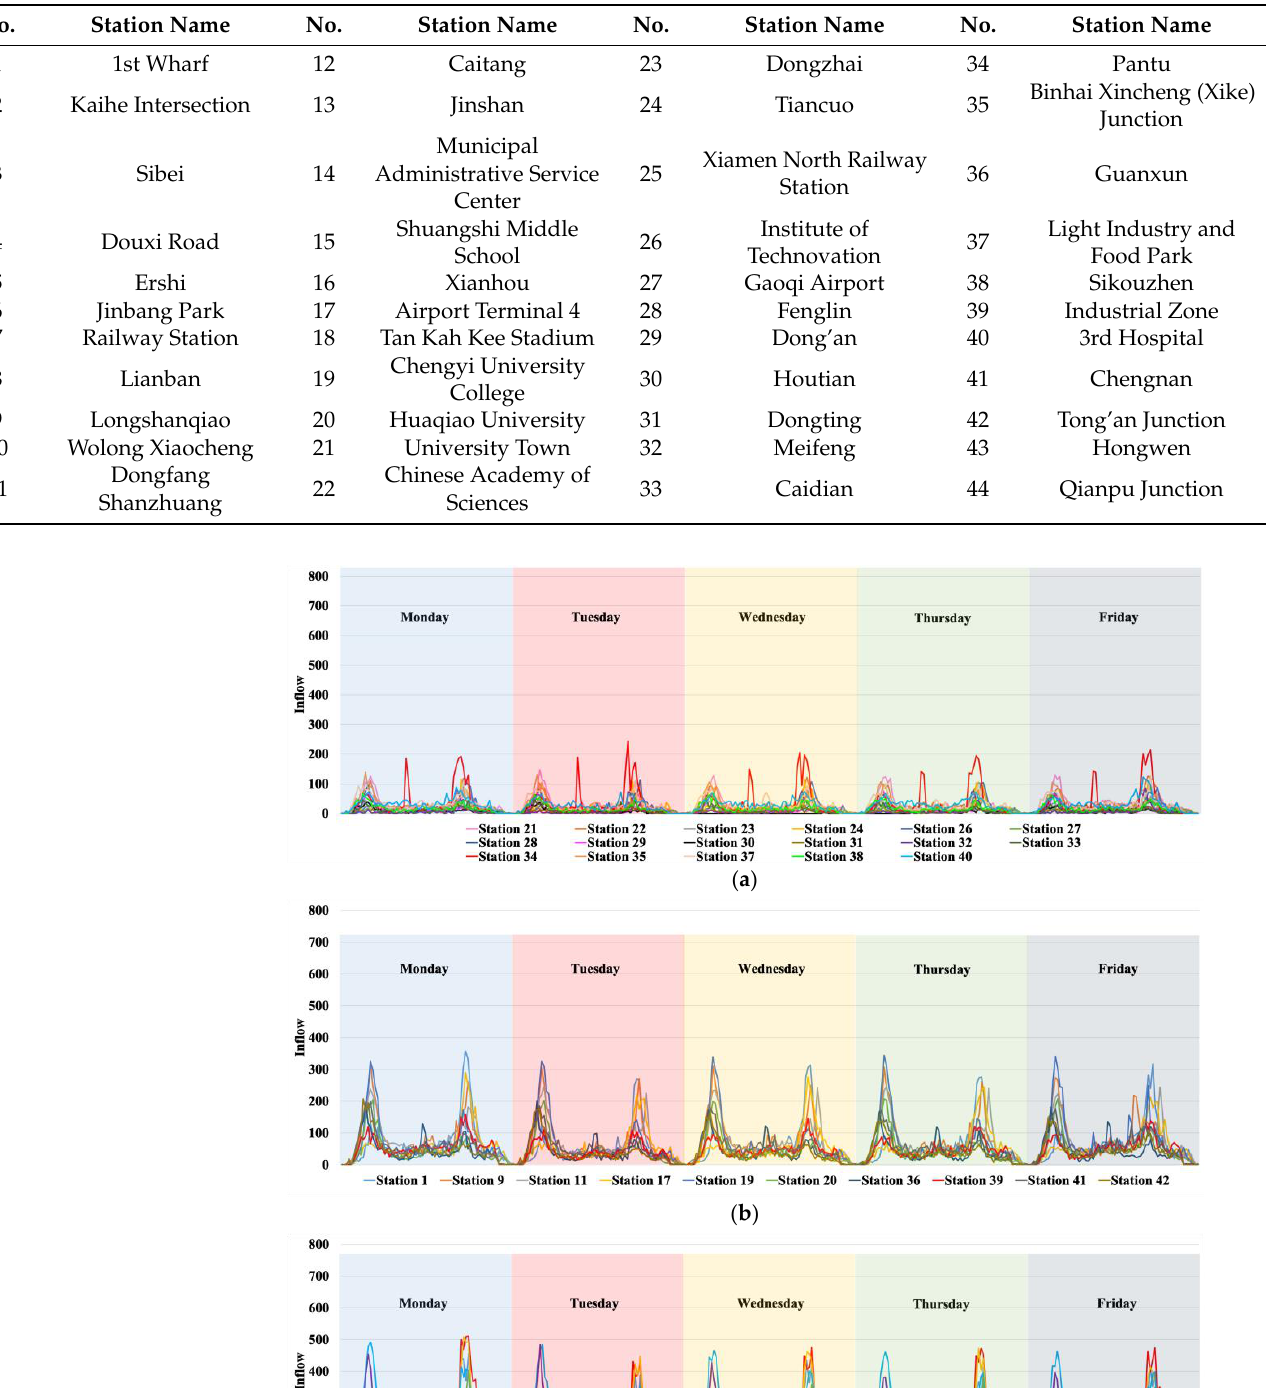
Table 5. Names of stations in the Xiamen BRT.